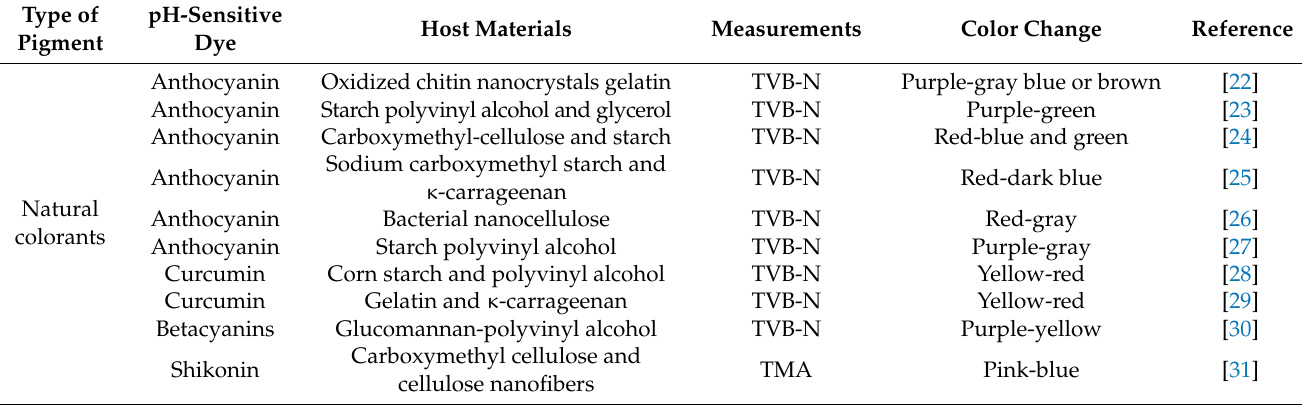
Table 1. Natural colorant indicators and synthetic dye indicators for fish freshness monitoring.